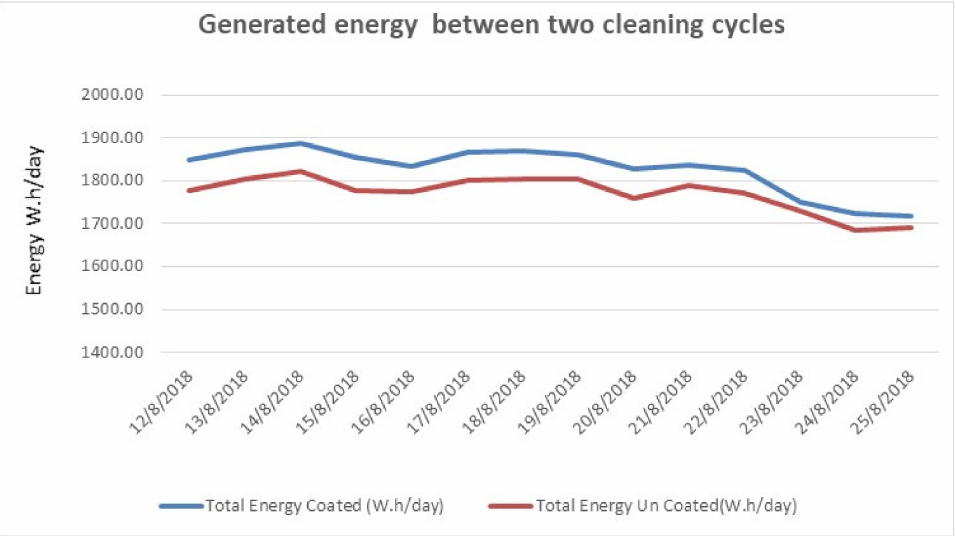
Figure 15. The daily generated energy between two cleaning